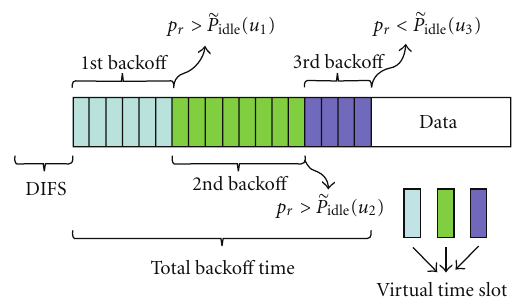
Figure 2: The conceptual diagram of iPro